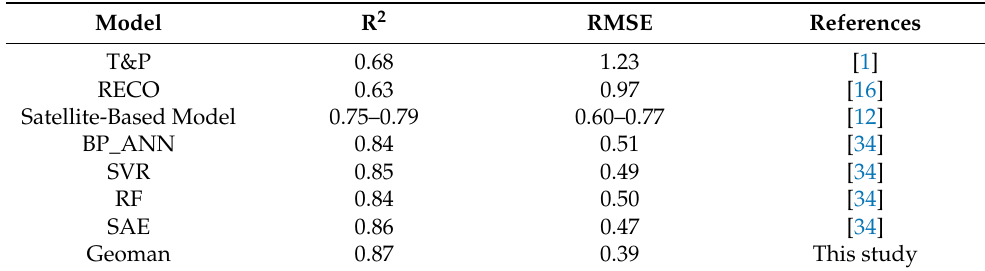
Table 6. The accuracy performance of different